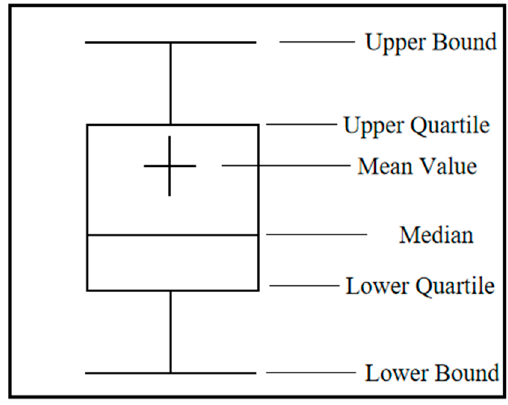
Figure 2. The structure of the box plot.